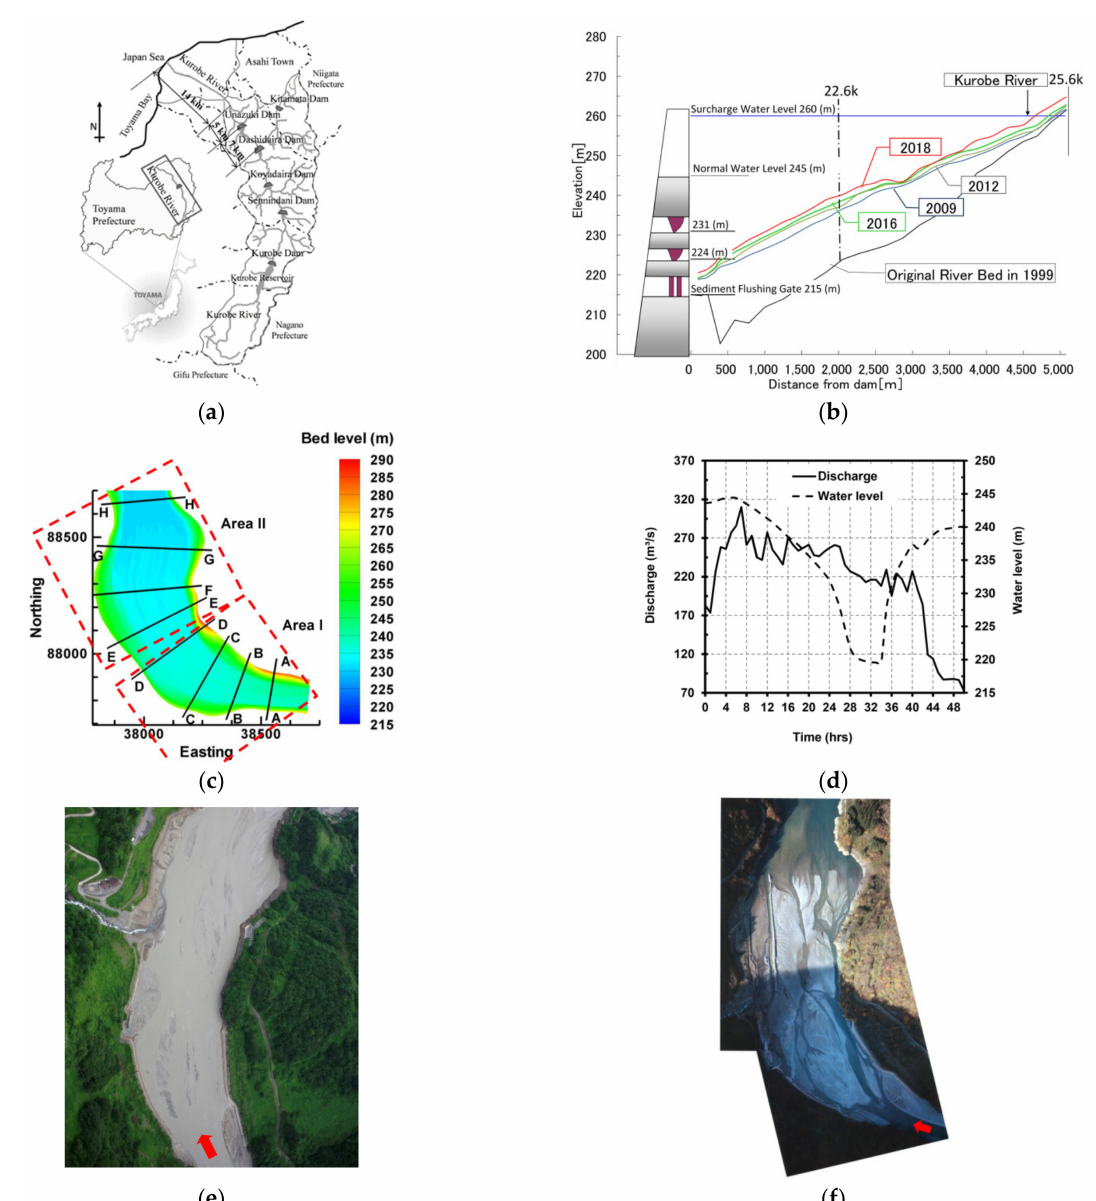
Figure 1. ( a ) Site map of the Kurobe River illustrating the location of the Unazuki Reservoir [23]. ( b ) Measured longitudinal profile of the Kurobe River relative to the location of the Unazuki Reservoir. ( c ) Measured bed topography of the Unazuki Reservoir before the flushing operation in June 2012 and locations of cross-sections A–H for further assessment of bed variations upstream (i.e., Area I) and downstream (i.e., Area II) of the study segment. ( d ) Water level and discharge rates during the flushing operation in June 2012. ( e ) Aerial photograph of the Unazuki Reservoir taken during the free-flow showing sandbar development within the reservoir. ( f ) Aerial photograph showing the distributed scouring channels after the flushing operation in the study segment in the Unazuki Reservoir. Photographs 1 ( e ) and ( f ) provided by the Kurobe Office of River; red arrows show the flow